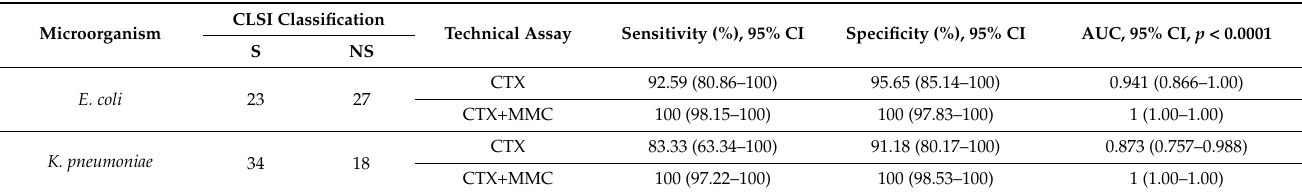
Table 1. Analytical evaluation of the technical assays of cotrimoxazole-induced cell elongation (CTX) and cotrimoxazole prevention of mitomycin C-induced cell enlargement (CTX+MMC), in comparison with the categorization by the standard antibiogram and CLSI criteria of Escherichia coli and Klebsiella pneumoniae strains. S: susceptible; NS: non-susceptible; AUC: area under the receiver operating characteristic (ROC)